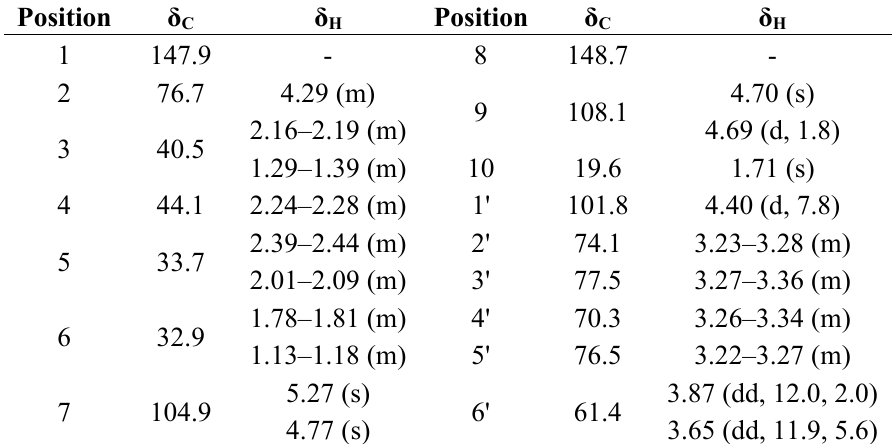
Table 1. 1 H- (400 MHz) and 13 C-NMR (100 MHz) data (CD Chemical shifts δ in ppm relative to TMS, J in Hz.